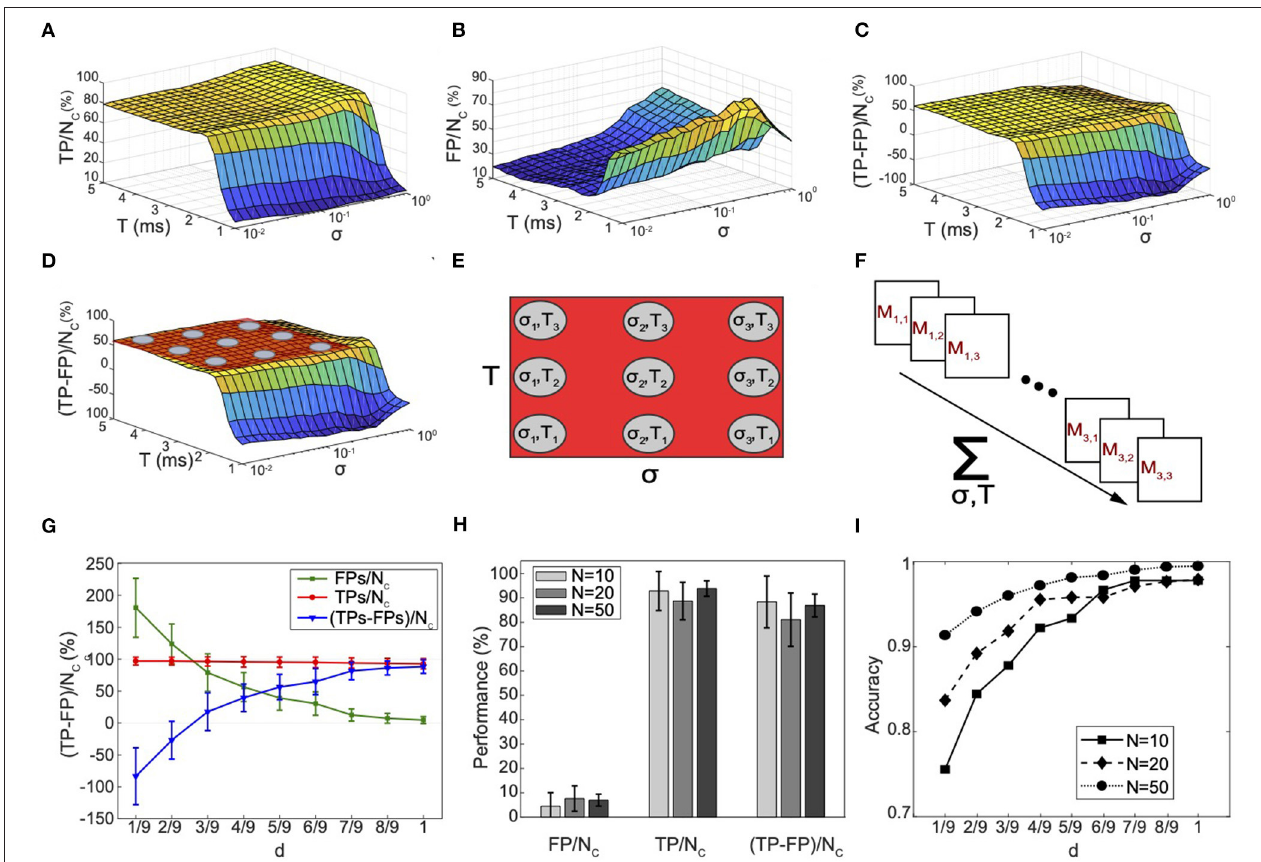
FIGURE 4 | Connectivity reconstruction and performance evaluation in synthetic neuronal networks. (A–C) Evaluation of the performance of the connectivity method under varying time window ( − T , + T ), standard deviation σ , and for a fixed ǫ = 0.7 ms, for one simulated network of 10 neurons. (A) Net number of detected true positives TP / n c . (B) Net number of FPs FP / n c . (C) Ratio 1 = ( TP − FP ) / n c as chosen metric for evaluation. n c is the known total number of connections in the simulated network. (D) Visual highlight on the behavior of 1 : a peak of performance is reached around 65%; low variability is proven for a wide range of T and σ (plateau indicated by the red plane). (E) Definition of a collection of K = 9 points p in the T - σ space for which the algorithm shows performances falling in correspondence of the plateau area. (F) Abstract representation of the statistical method for recognition of FPs connections and connectivity reconstruction. For each point a connectivity matrix M p is computed, resulting in the computation of K = 9 different connectivity matrices for the same input network. Combination of the results enables computation of the frequency f jk for each connection following Equation (9). (G) Average ( N = 20) performances computed at different discrimination threshold d . The TPs remain roughly constant. On the other hand, the FPs decrease and fluctuate around very small percentage. The algorithm filters out the FPs that fluctuate at high frequency reaching best performances (85%) at d = 1. (H) Analysis of scaling properties. An average ( N = 20) number of TP / n c , FP / n c , and 1 was computed for 20 randomly generated networks with 10, 20, and 50 neurons, respectively. Very good performances are maintained constant for increasing network size. (I) Accuracy ACC indicator computed for different network sizes as a function of the discrimination threshold d . The error bars stand for the standard deviation of a dataset of 20 different